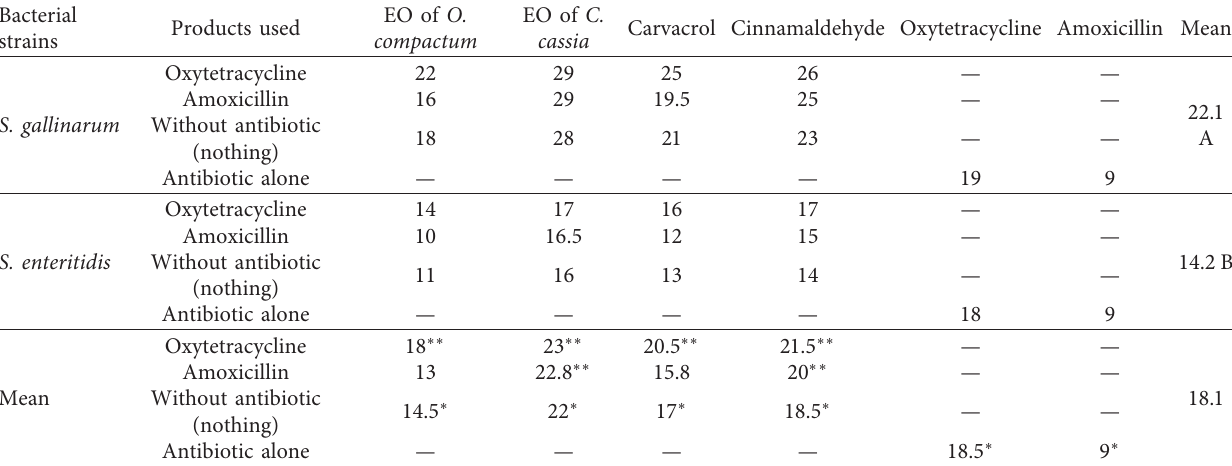
Table 6: Evaluation, by the disc method, of the effects of essential oils, active products, and antibiotics on the inhibition diameter (mm). Bacterial Products used strains